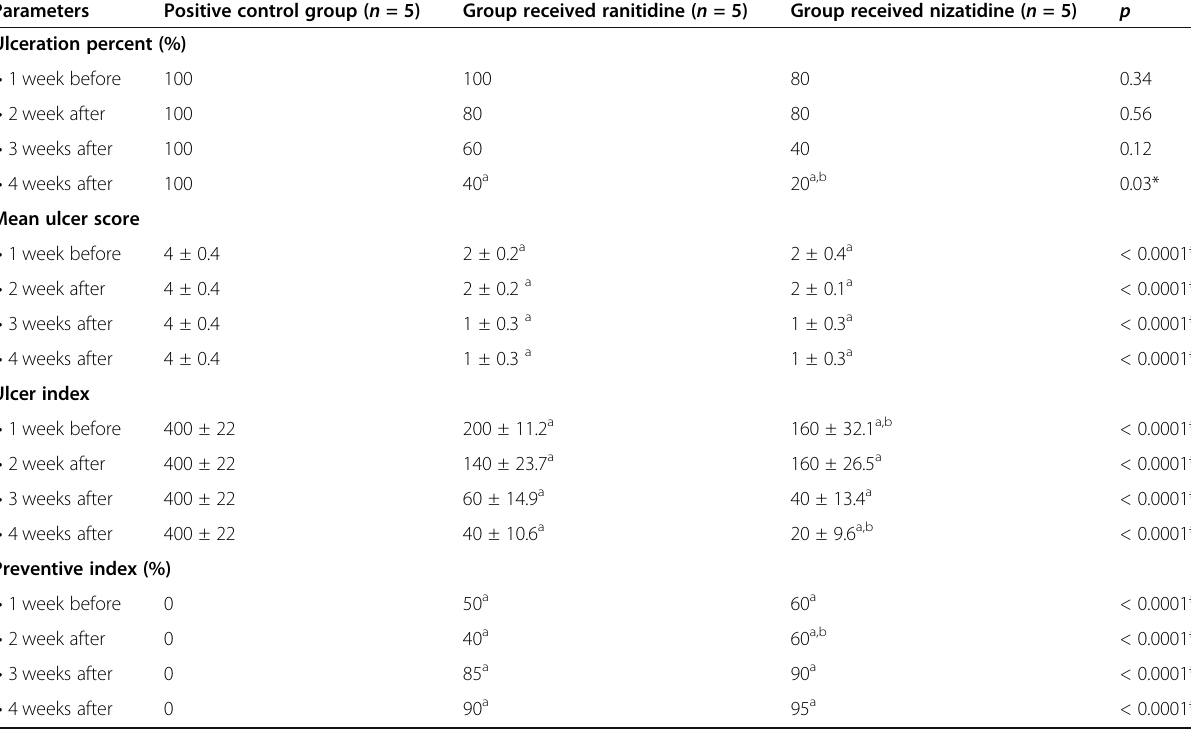
Table 1 Effects of oral administration of nizatidine and ranitidine (27 mg/kg b. wt.) on ulceration in rats administrated